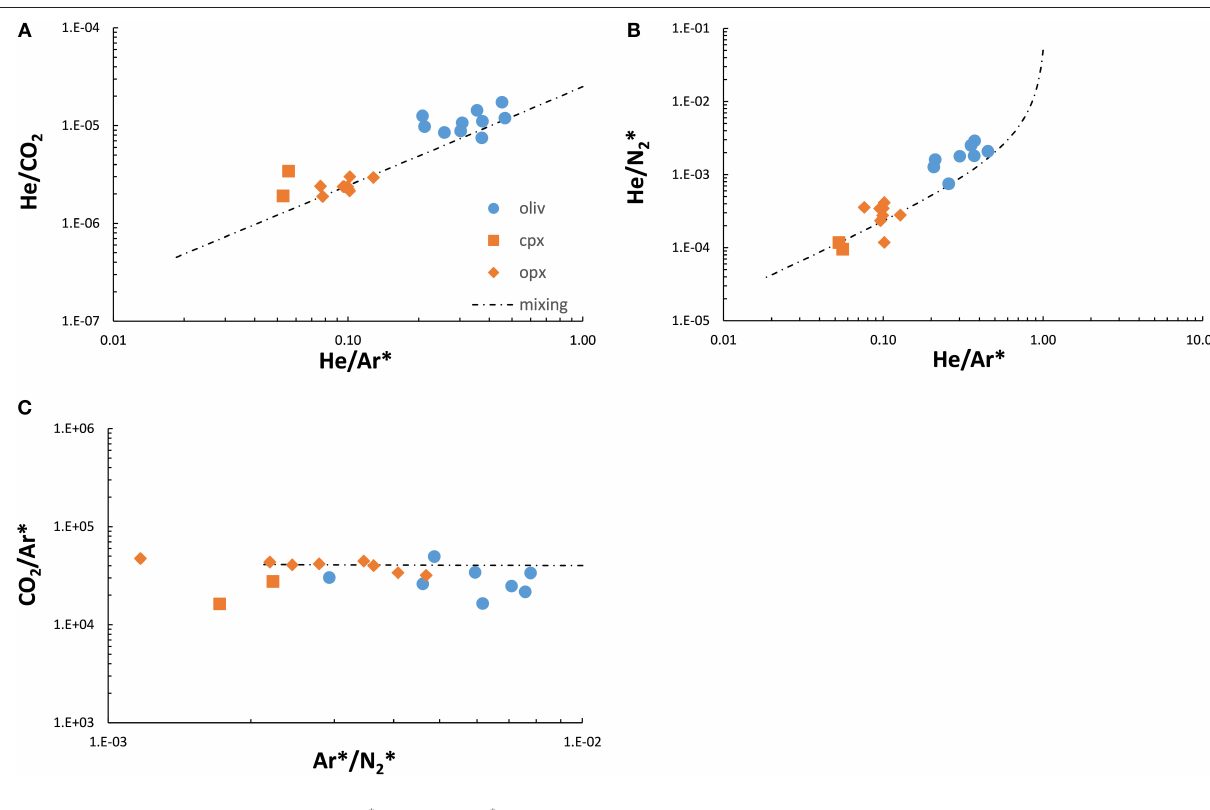
FIGURE 8 | He/Ar* vs. (A) He/CO 2 and (B) He/N * 2 , and (C) Ar*/N * 2 vs. CO 2 /Ar* in FI. The black dotted line represents binary mixing between two endmembers: (1) the residual mantle having He/Ar* = 1, He/CO 2 = 2.5 × 10 − 5 , He/N * 2 = 5 × 10 − 2 , Ar*/N * 2 = 5 × 10 − 2 , and CO 2 /Ar* = 4 × 10 4 , and (2) the metasomatic agent having He/Ar* = 1.7 × 10 − 2 , He/CO 2 = 3.7 × 10 − 7 , He/N * 2 = 3.7 × 10 − 5 , Ar*/N * 2 = 2.1 × 10 − 3 , and CO 2 /Ar* = 4.7 × 10 4 . These two endmembers were assumed based on the minimum and maximum concentrations of single species in the three mineral phases and in order to fit the entire data